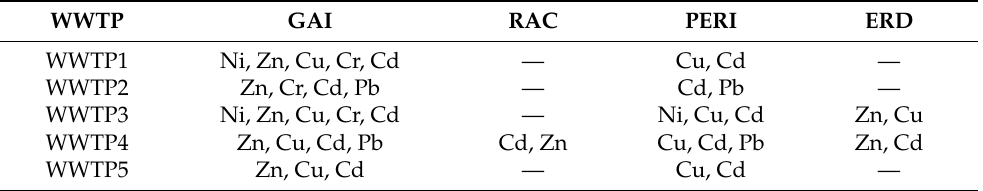
Table 7. Schedule of failure to meet heavy metal toxicity criterion from analyzed sites for four pollutant